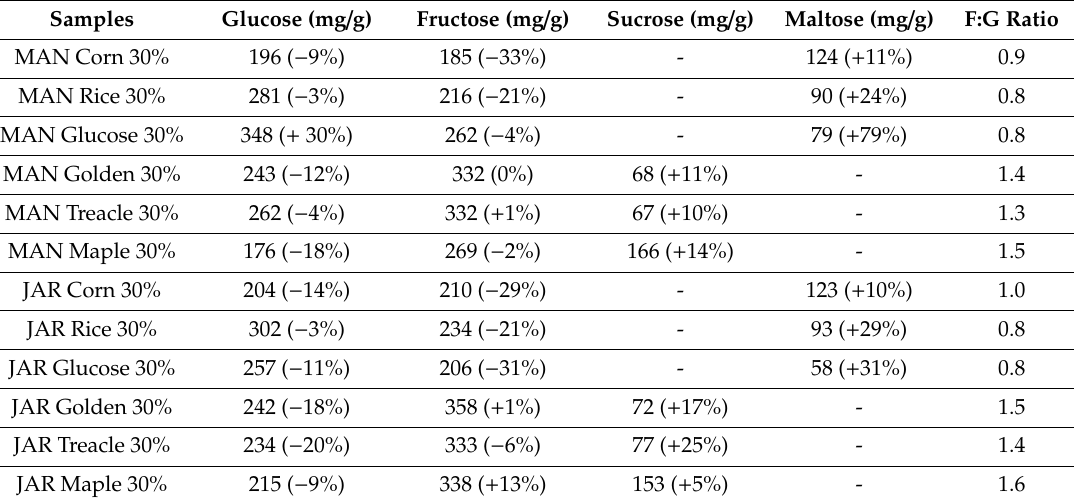
Table 3. Experimentally determined content 1 (and variation from the theoretical value) of various sugars in artificially adulterated Manuka (MAN) and Jarrah (JAR) honeys, and their fructose to glucose ratio